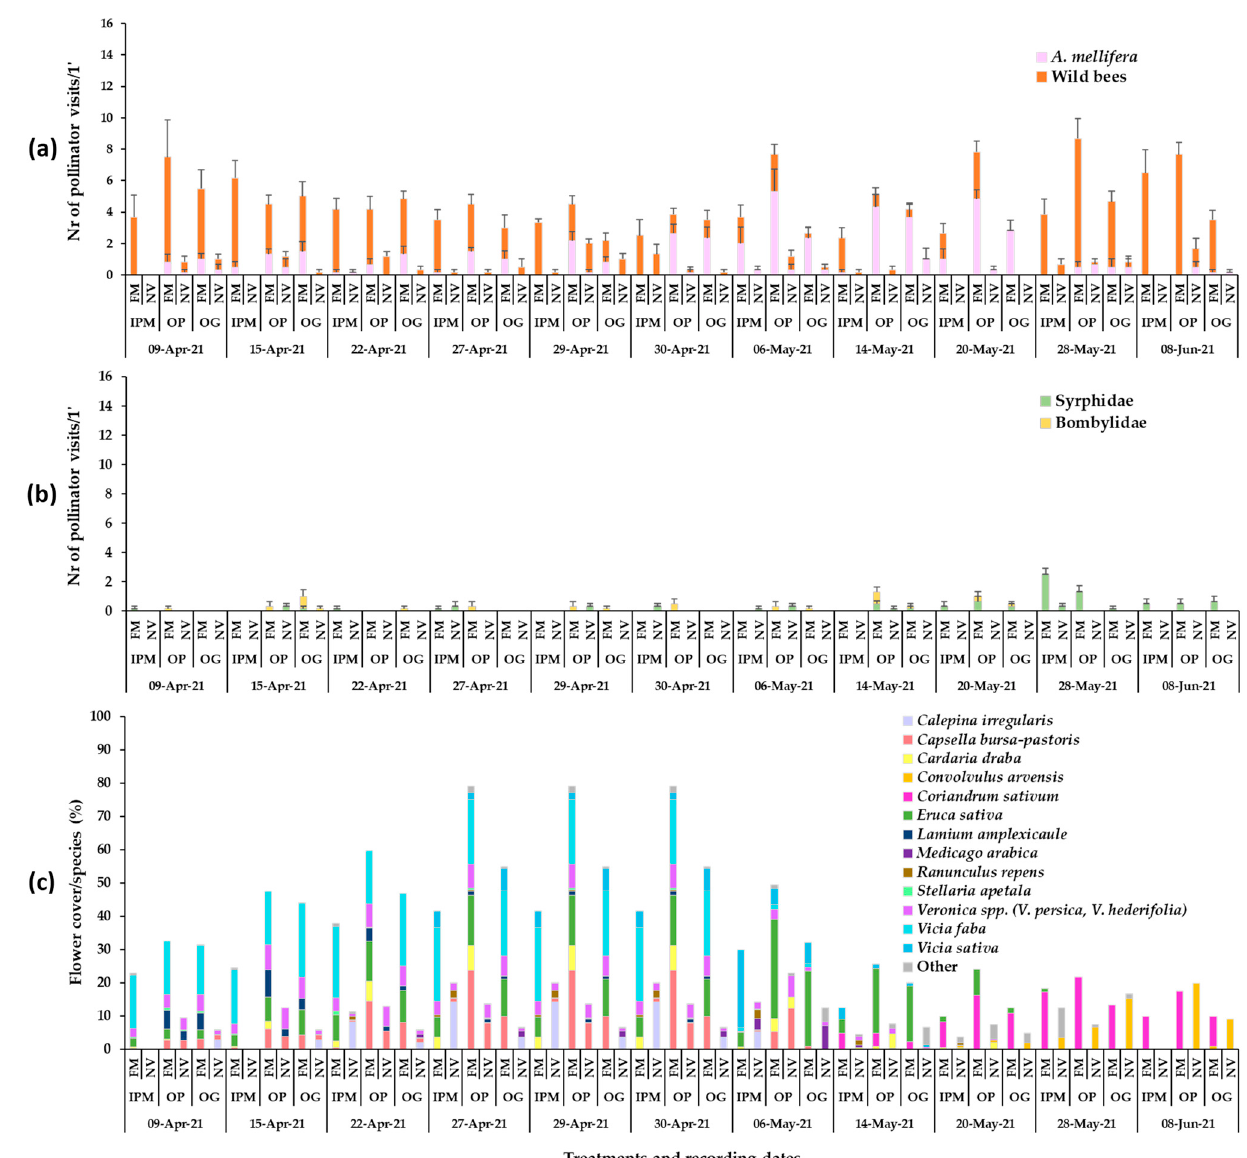
Figure 3. Mean numbers of ( a ) Hymenoptera, ( b ) Diptera pollinator visits (honey bees, wild bees) and Diptera visits on ground cover patches (1 min/6.4 m 2 ) in apple orchards and ( c ) mean flower cover percentage per plant species in the patches in year 2021. FM: sown flowering mixture; NV: natural vegetation (wild plants); IPM: IPM orchard, OP: organic palmette orchard, OG: organic goblet orchard. Vertical bars represent standard error of means. Other species: Brassica nigra , Cardamine hirsuta , Geranium disectum , Malva spp., Matricaria chamomila , Medicago polymorpha , Poa annua , Raphanus sp., Senecio vulgaris , Sonchus oleraceus , Taraxacum officinale , Trifolium repens , Alopecurus myosuroides